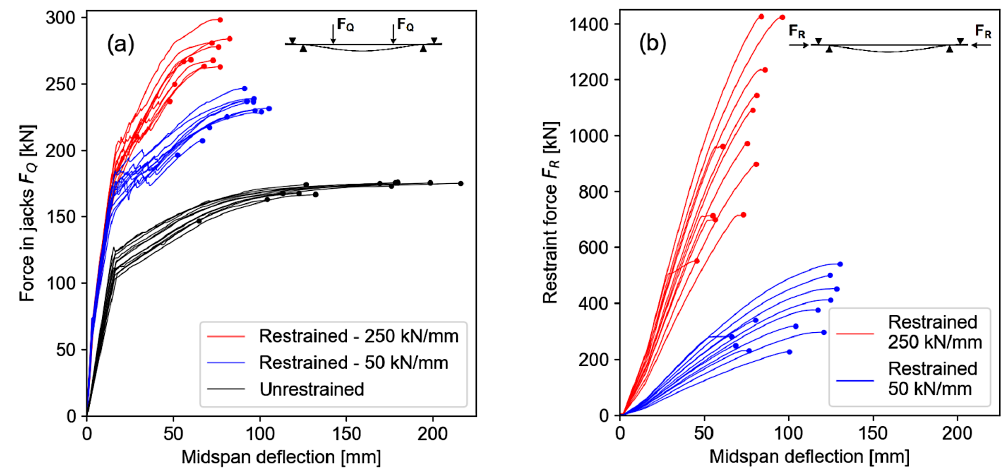
Figure 6. LHS samples of restrained and unrestrained hollow core slabs; (a) the load-displacement curves (b) restraint force versus displacement curves.